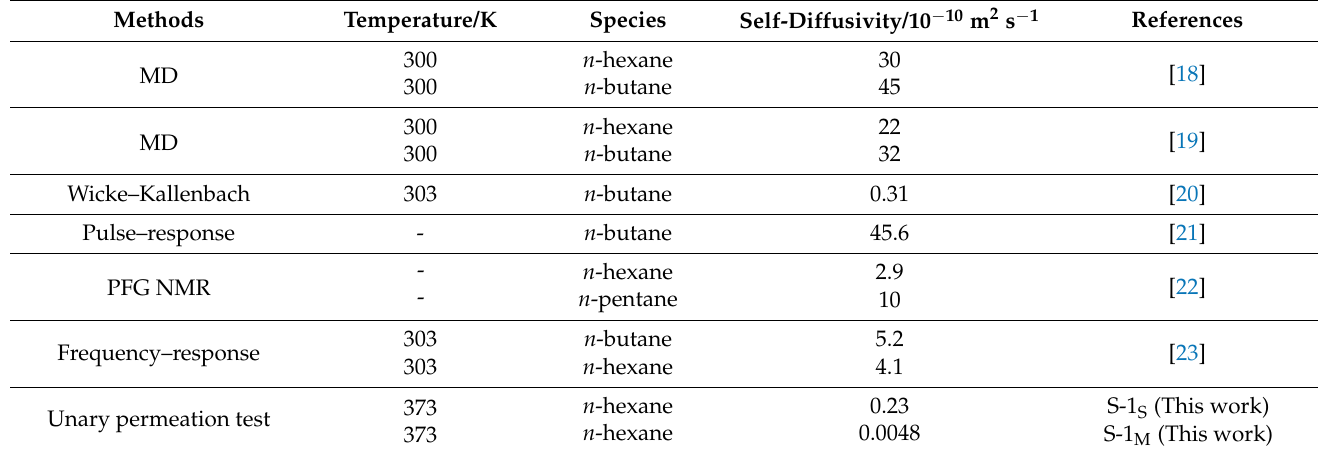
Figure 6. Arrhenius plot for diffusion of ( a ) n -hexane and ( b ) 2-methylpentane. ○ , S-1 S ; □, S-1 M .